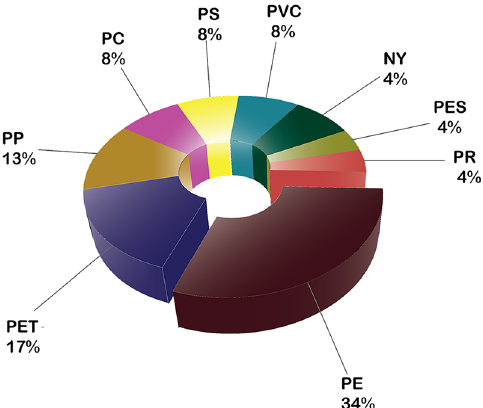
Fig. 7 Distribution of MPs at risk of transport via runoff from the corn and soybean fi elds in the state of Nebraska at a county level. Blue lines represent the major streams at risk of MP contamination.